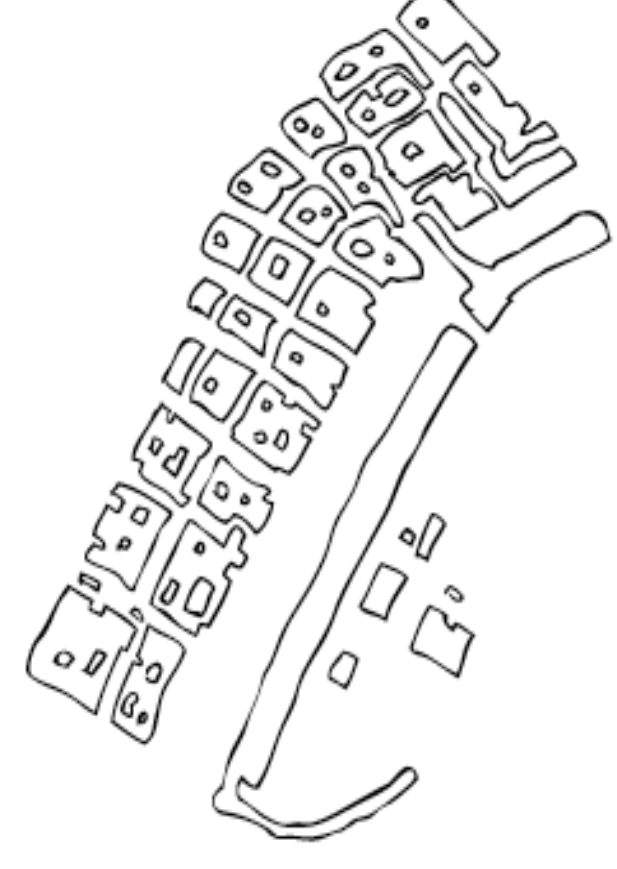
Figure 3. “When I cross the door of the club it was like passing the finishing line of a long walk that I did for